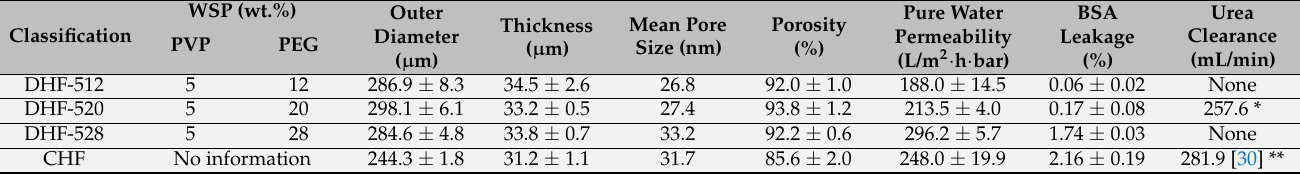
Table 4. Properties of DHF and CHF